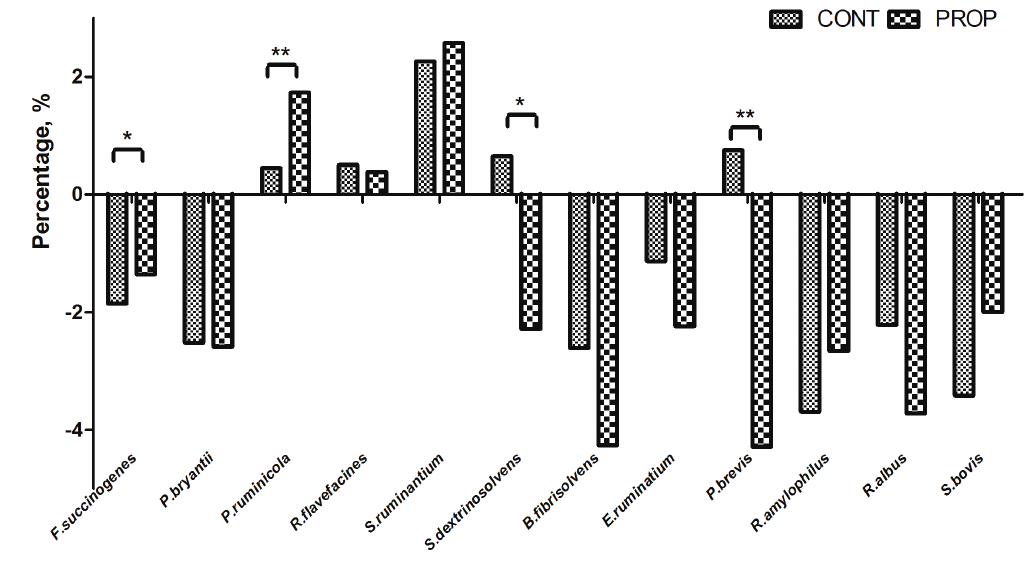
Figure 4. Difference in relative abundance of selected bacterial species between control feeding group (CONT) and calcium propionate supplementation (PROP). Percent data were common log-transformed prior to analysis. Asterisk shows significant differences between groups (** p<0.01, * p<0.05, T test, SAS, Institute, Cary, NC,